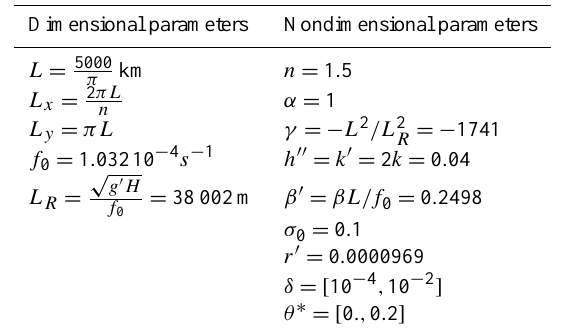
Table 1. Dimensional and nondimensional parameters used in the coupled ocean–atmosphere